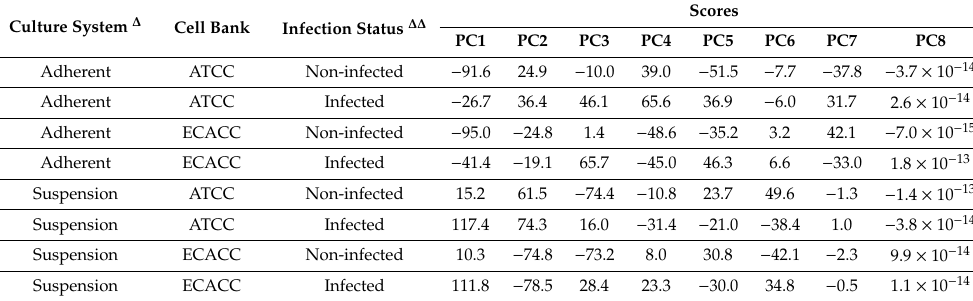
Table A1. Principal component analysis scores.